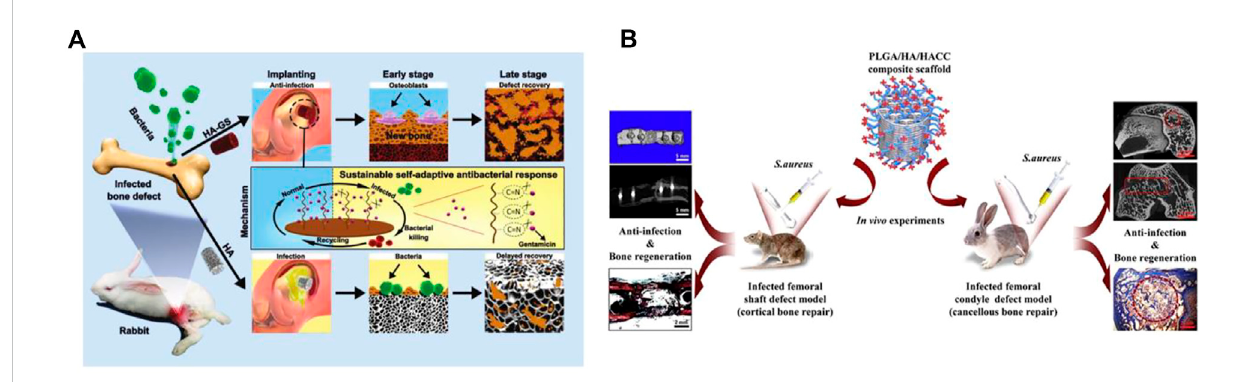
FIGURE 6 (A) Schematic diagram of stimulus-responsive HAp-GS material fabrication and its biological applications. (B) Schematic diagram of the experimental protocol for PLGA/HAp/HACC antimicrobial materials. (A) Reproduced with permission (Jin et al., 2019). Copyright 2019, Advanced Functional Materials. (B) Reproduced with permission. Copyright 2018, Acta